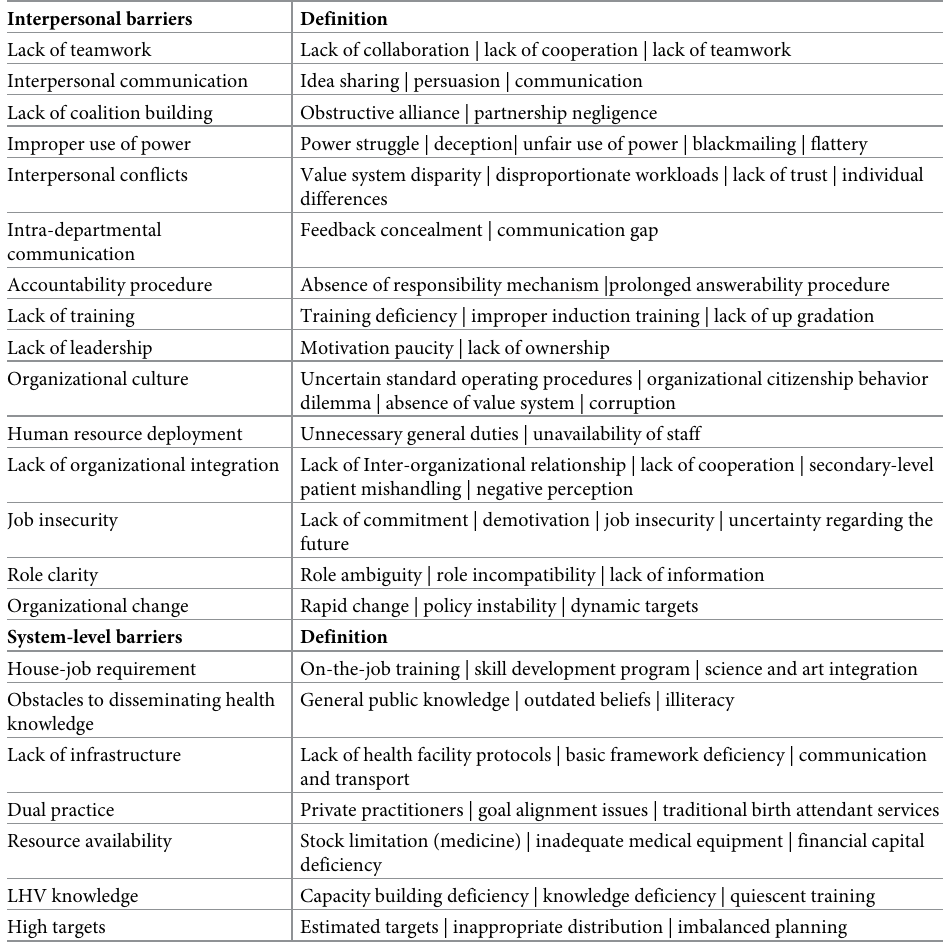
Table 1. Categories of interpersonal, organizational and system-level